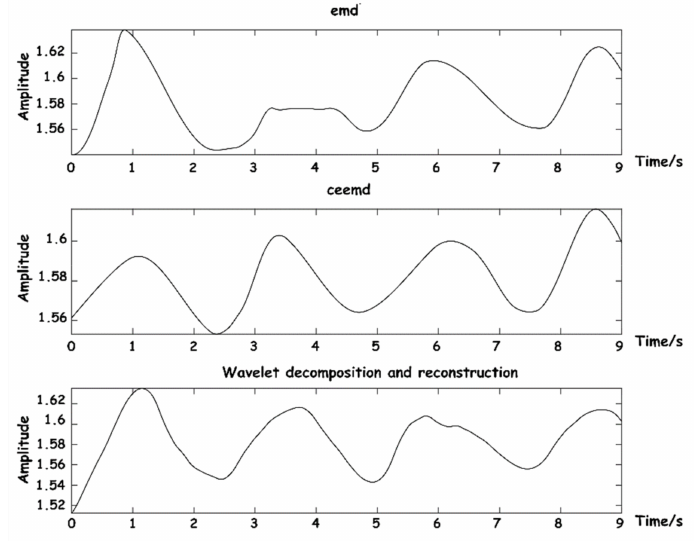
Figure 11. Diagram of respiratory signal reconstruction